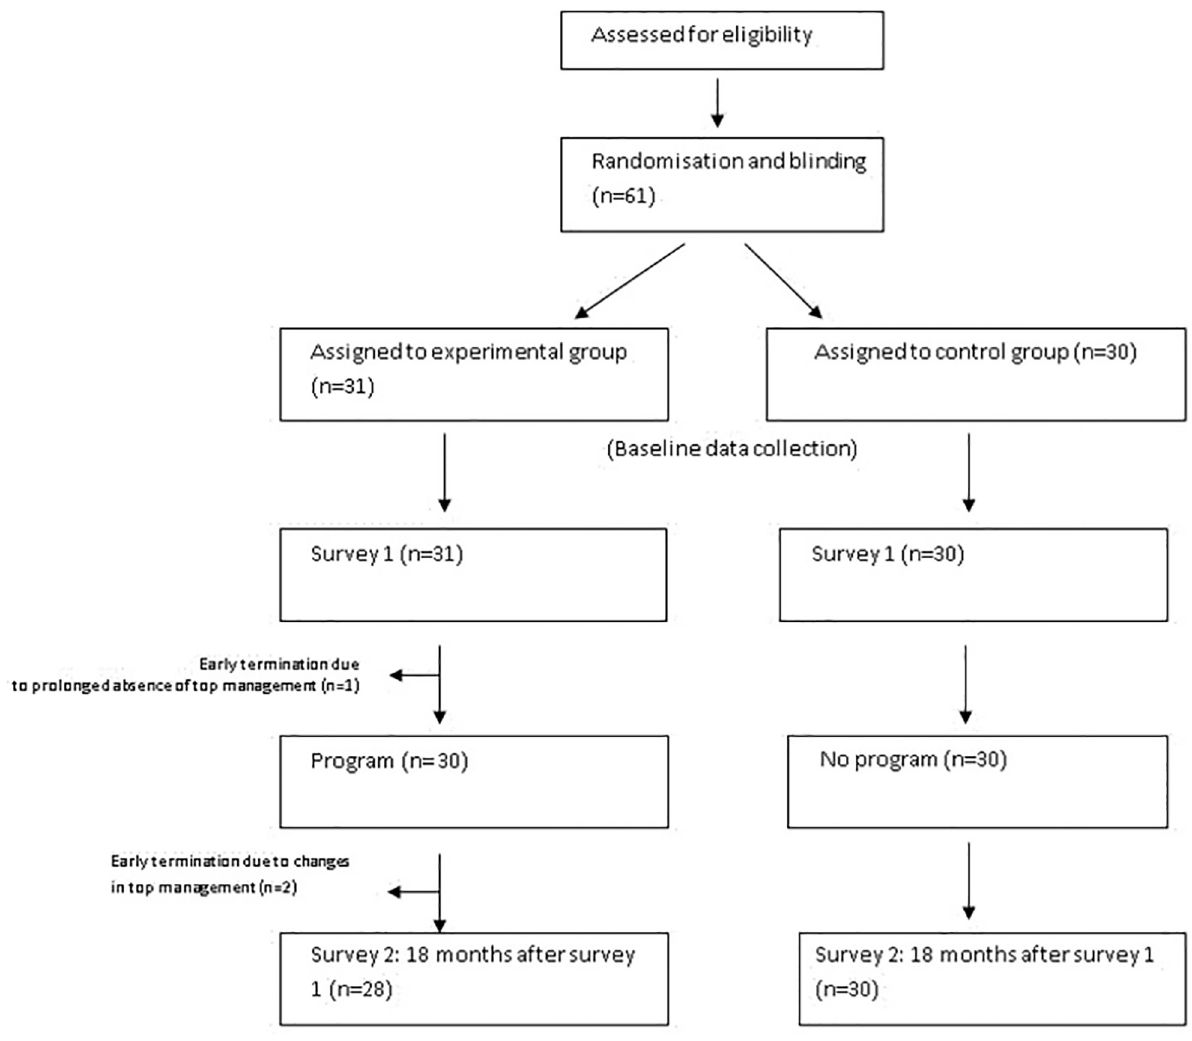
Fig 1. Flow chart of the study in control and intervention groups.